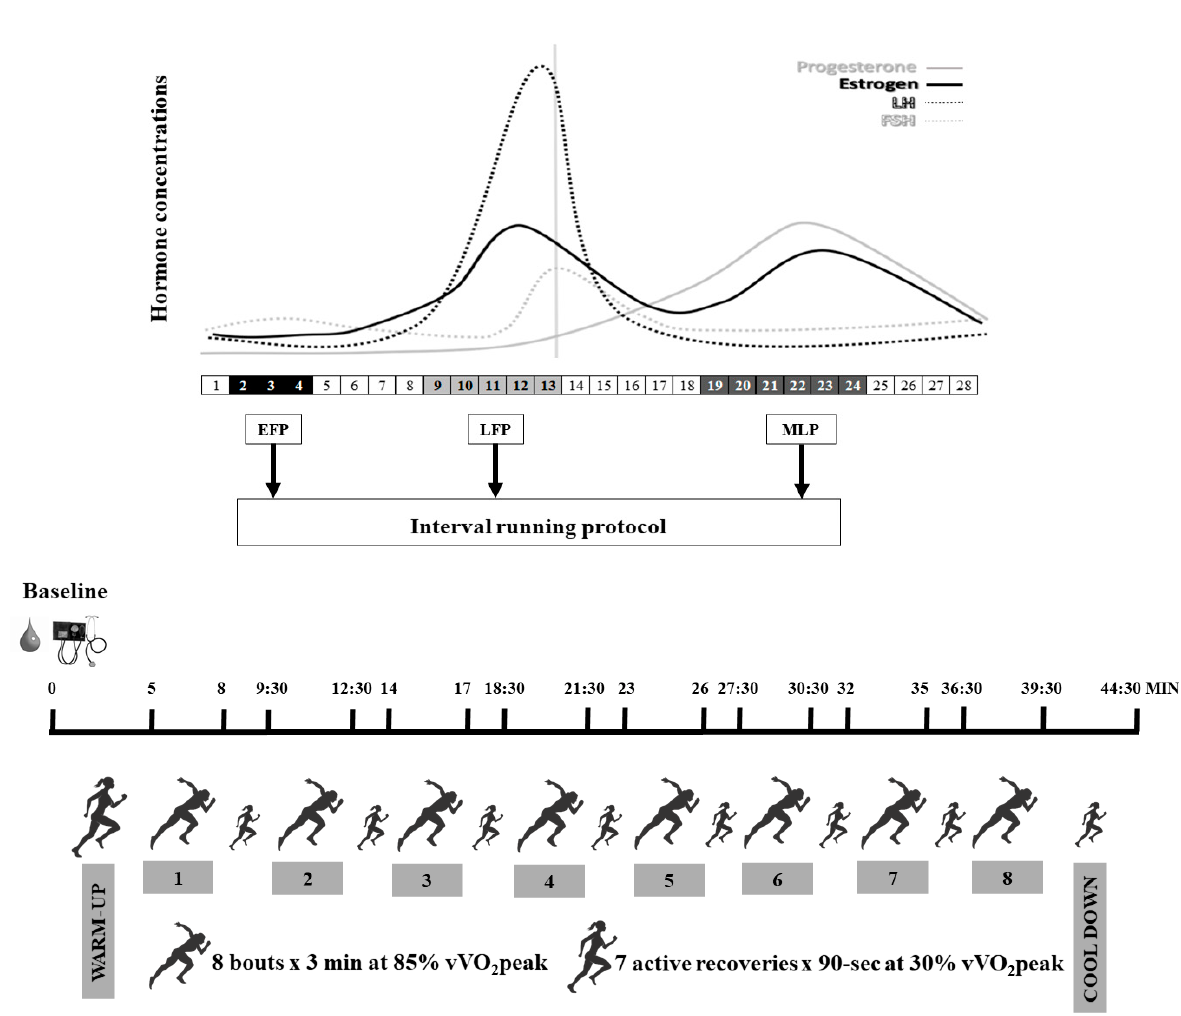
Figure 1. Protocol of the testing procedure day. EFP: early-follicular phase; LFP: late-follicular phase; MLP: mid-luteal phase; v VO 2 peak: maximal aerobic speed.